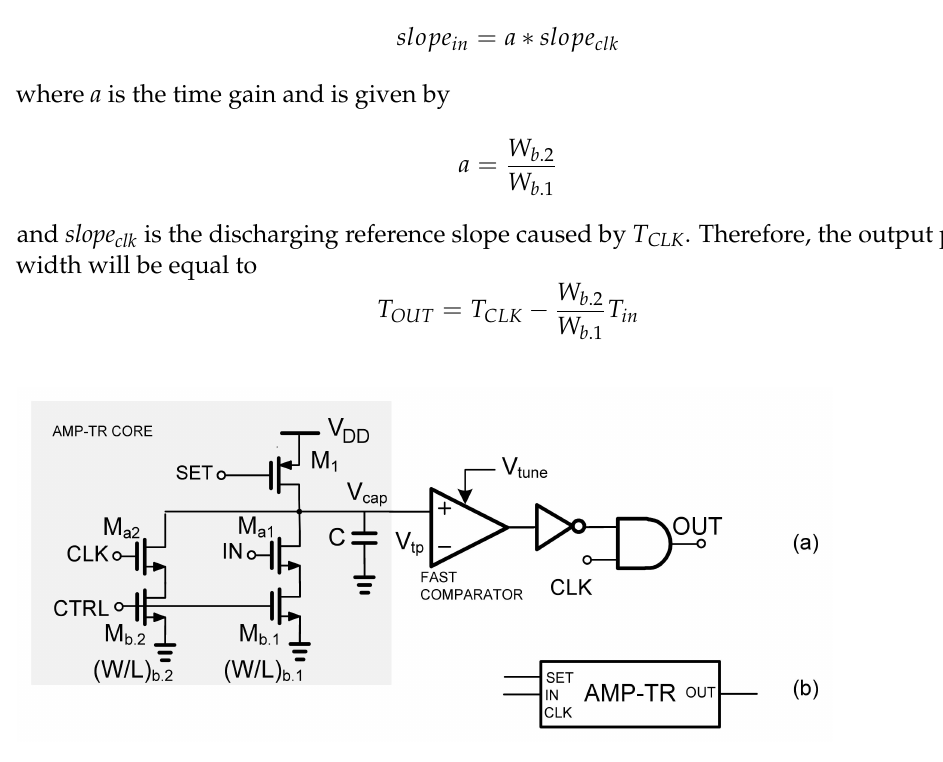
Figure 4. ( a ) Time amplifier based on time register circuit and ( b ) symbol.